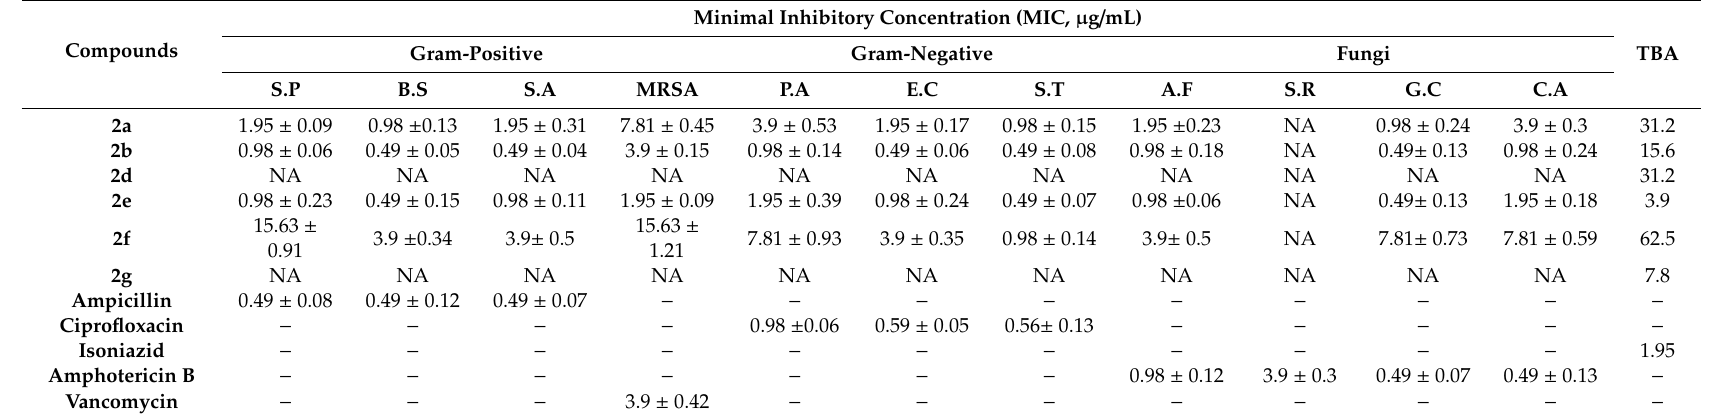
Table 6. Antimicrobial activity of the synthetic compounds (minimum inhibitory concentration (MIC), µ g / mL).